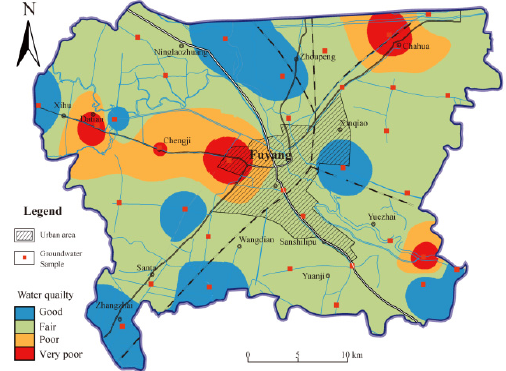
Figure 5. Spatial distribution of shallow groundwater quality based on fuzzy comprehensive assessment result.